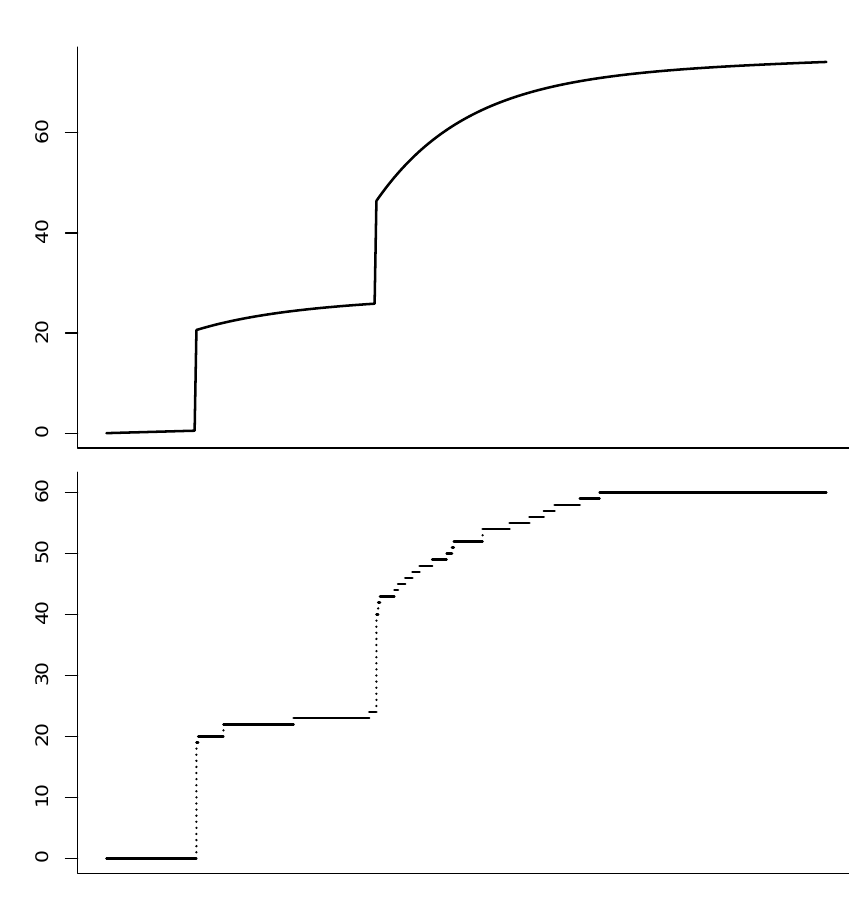
Figure 2. Illustration of the cumulated shot-noise intensity L with exponential structure and jumps ( α (cid:54) = 0 ). The graph on the bottom shows a counting process whose jump times have cumulated intensity process L . Multiple claim arrivals occur when L